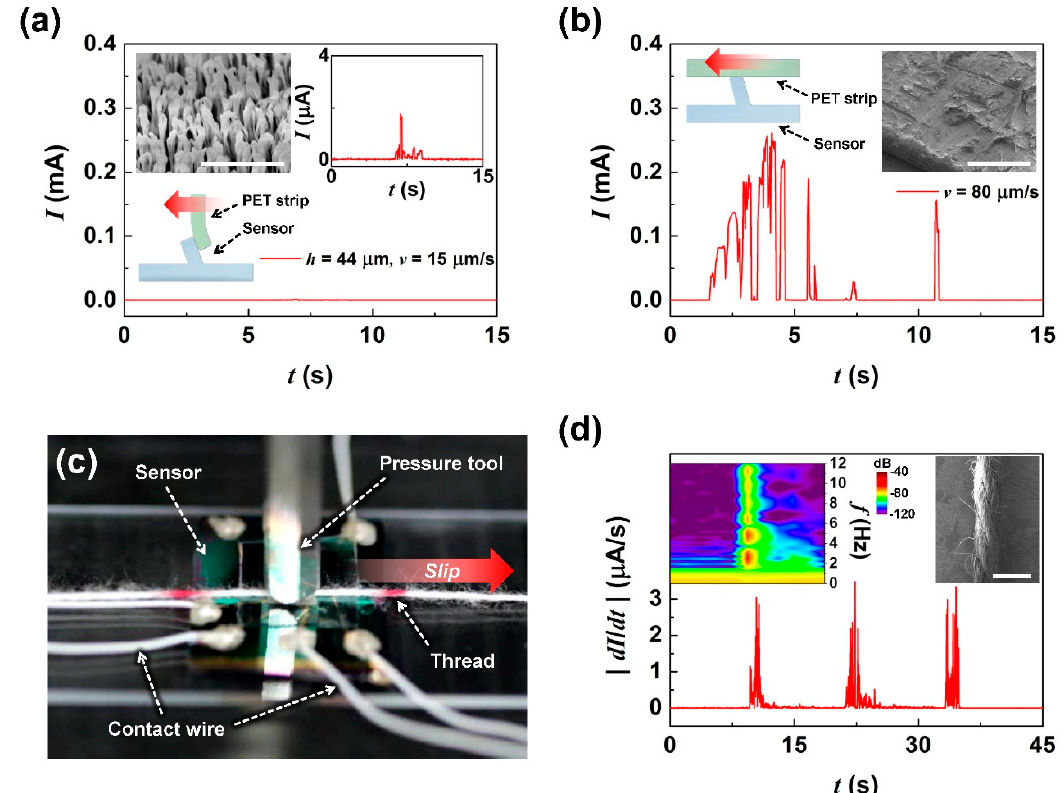
Figure 4. Friction, roughness and slip-sending characteristics of the tactile shear sensor: ( a ) low friction PET with nanobrush scanning result. Inset shows the SEM image of nanobrushes (tool bar indicates 1 μ m); ( b ) rough PET surface scanning result. Rough PET surface formed by rubbing with sandpaper. Inset shows an SEM image of the rough PET surface (tool bar indicates 300 μ m); ( c ) optical image of the measurement set-up testing the sensor’s slip motion detection capability using a polyester thread; ( d ) absolute value of differential current measured during the slip motion of the thread repeated three times. Left inset shows the short-time Fourier transform (STFT) result at 0~18 s. Right inset shows the SEM images of a polyester thread (tool bar indicates 1 mm).